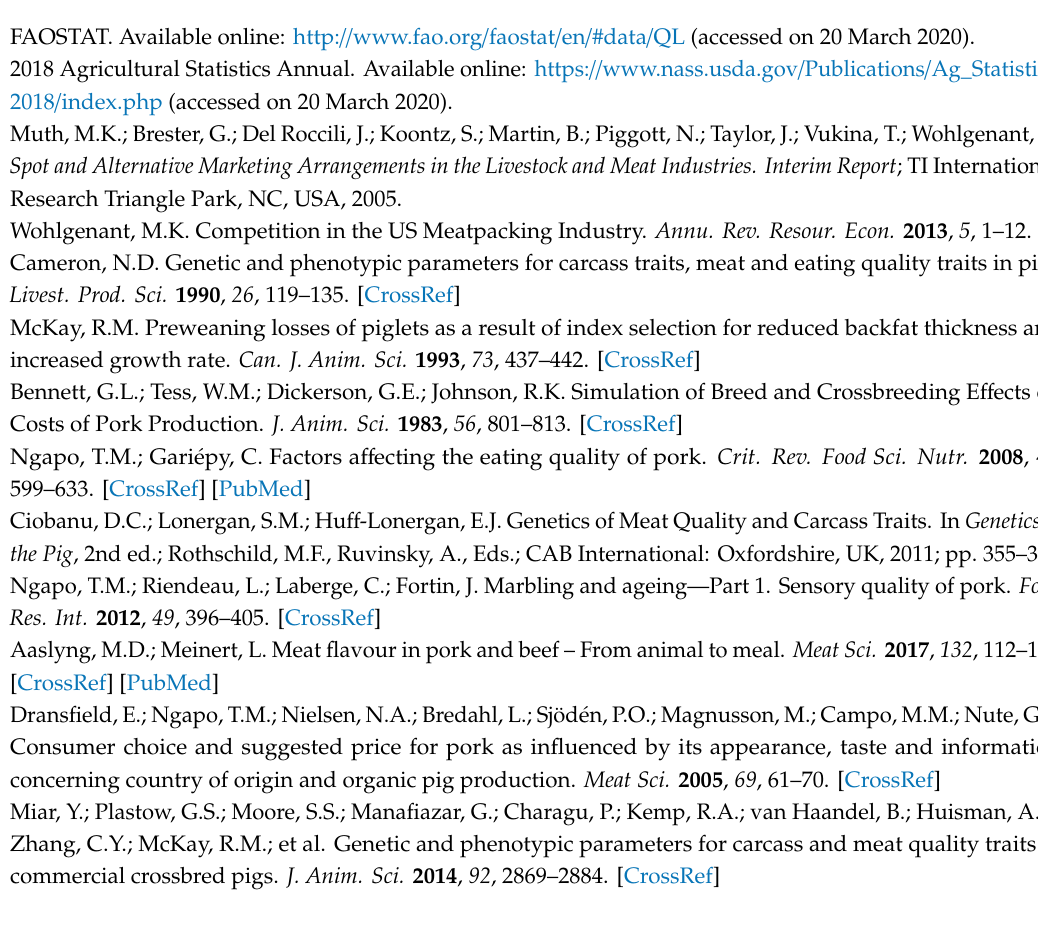
Table S1: Heritabilities and phenotypic and genetic correlations for all